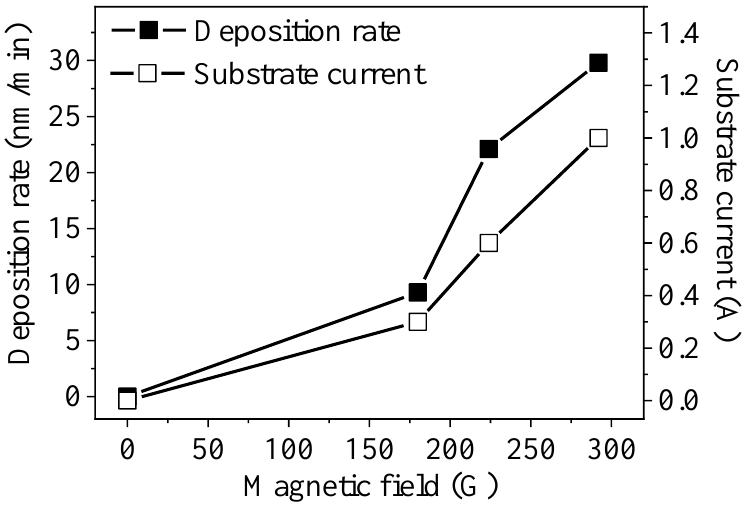
Figure 3. Deposition rate and substrate current as functions of the magnetic field. The distribution of MP density under different magnetic fields of the filter duct is shown in Figure 4. The largest population of MPs was in the range of 0.5 to 1 μm . The MP density increased with the increasing magnetic field and thus increasing plasma density.